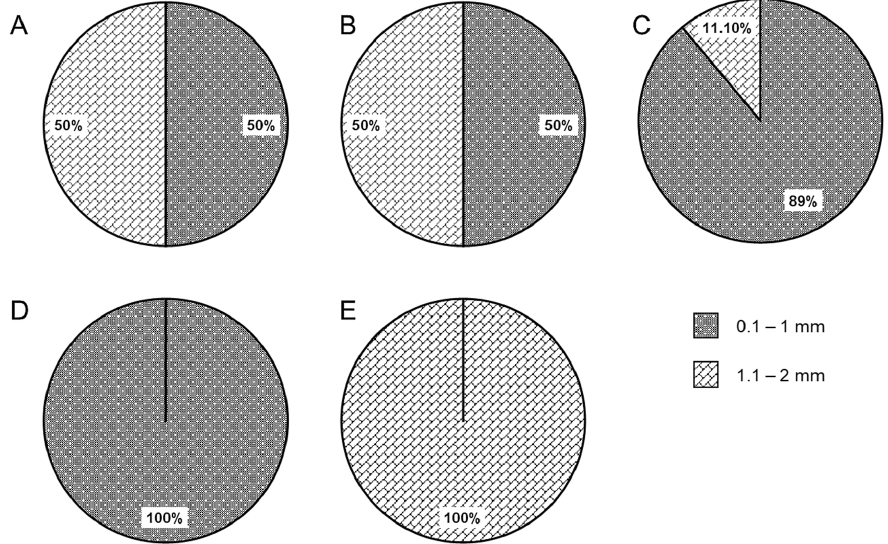
Figure 7. Size classes (%) of microplastics found in ( A ) seawater, ( B ) distilled water + NaCl, ( C ) purged water in 3 h, ( D ) purged water in 6 h, ( E ) purged water in 9 h.